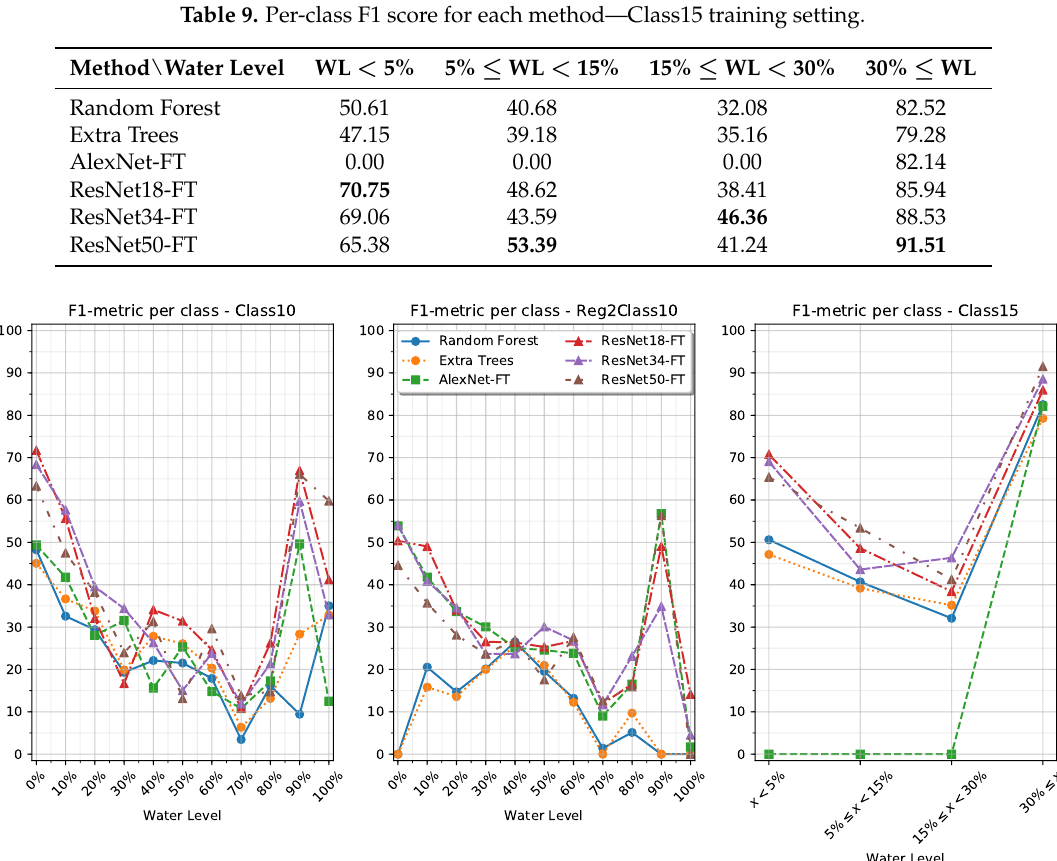
Figure 4. Per-class F1-metric for all methods under the different training